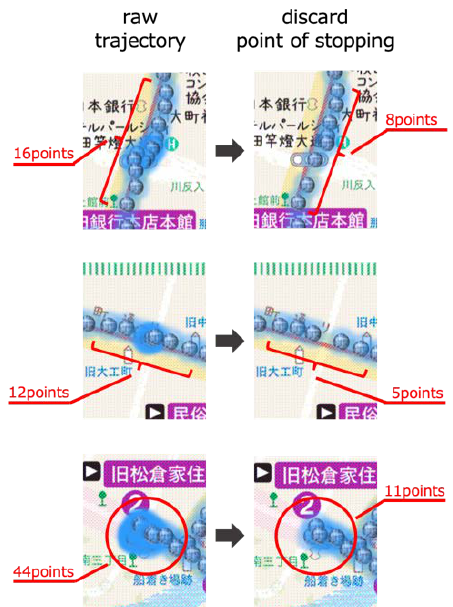
Figure 17. Examples of recognizing walking and stopping with the acceleration sensors’ threshold value set at Th 2 = 0.1 G . Blue dots show every 15-second point of a user’s trajectory data. Simplified trajectory data are effective in reviewing and playing back a user’s trajectory on the screen.